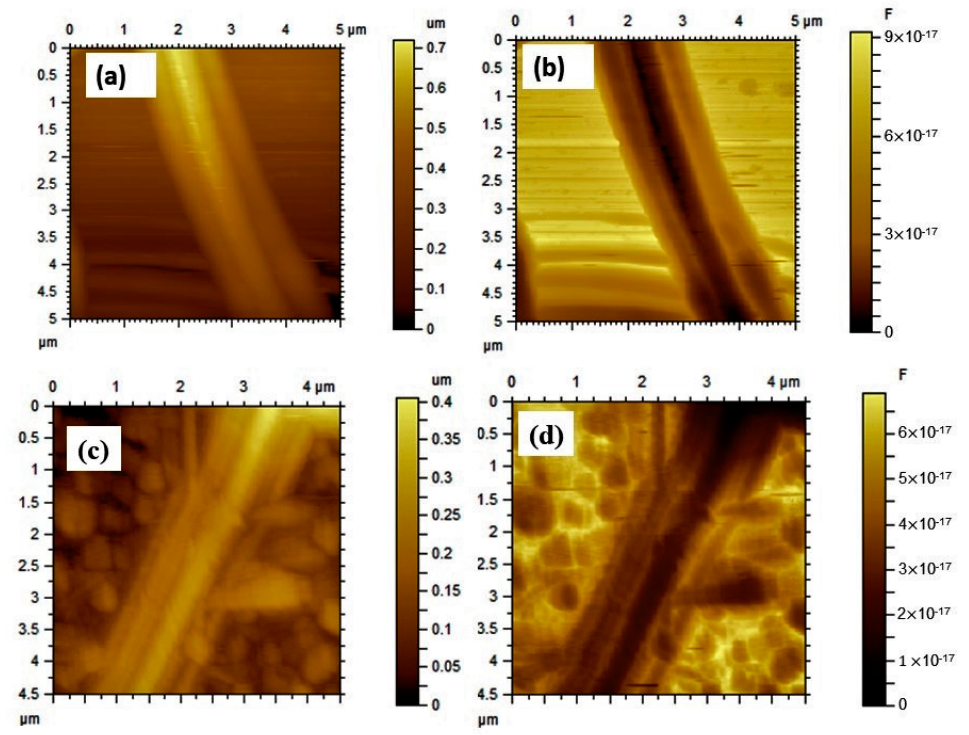
Figure 8. Scanning microwave microscopy (SMM) images recorded at 15.6 GHz showing ( a ) to- pography and ( b ) capacitance for a fiber with a BTO core and Zn 2 Y shell. Similar topography and capacitance images of a fiber with a Zn 2 Y core and PZT shell are shown in ( c , d ), respectively.